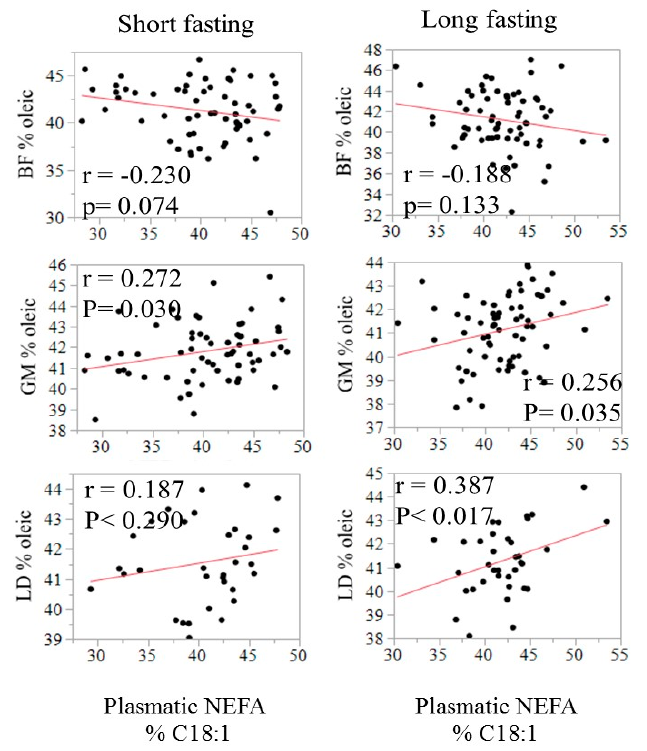
Figure 2. Relationship of the relative content (% of total fatty acids) of oleic acid in plasma with the relative content of oleic acid in SF, GM, and LT by fasting duration.